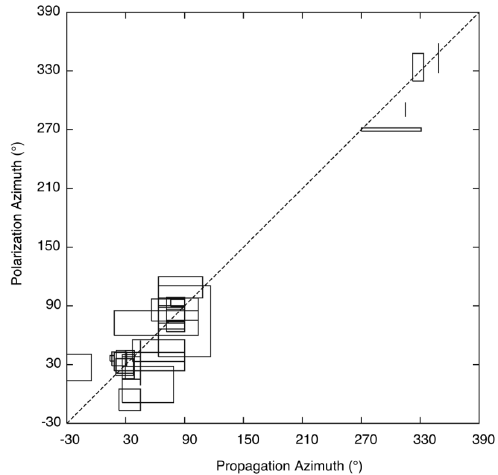
Fig. 14. Comparison of the propagation and polar- ization azimuths derived from analyses of P- waves arrivals. Width and height of the boxes correspond to the uncertainty on slowness and polarization esti-